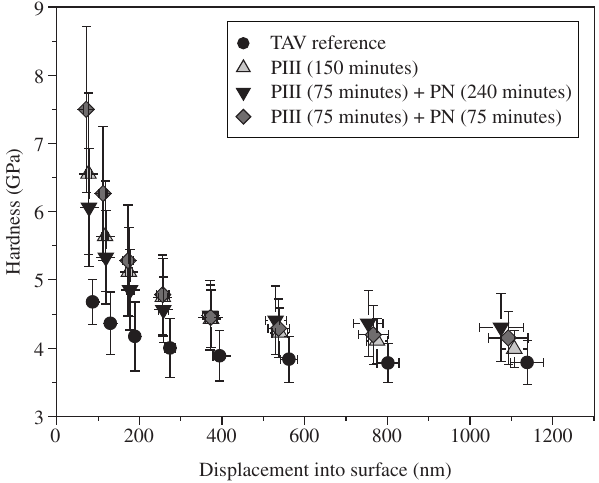
Figure 2. Superficial hardness (nanoindentation) of the samples treated ac- cording to Table 1 including reference